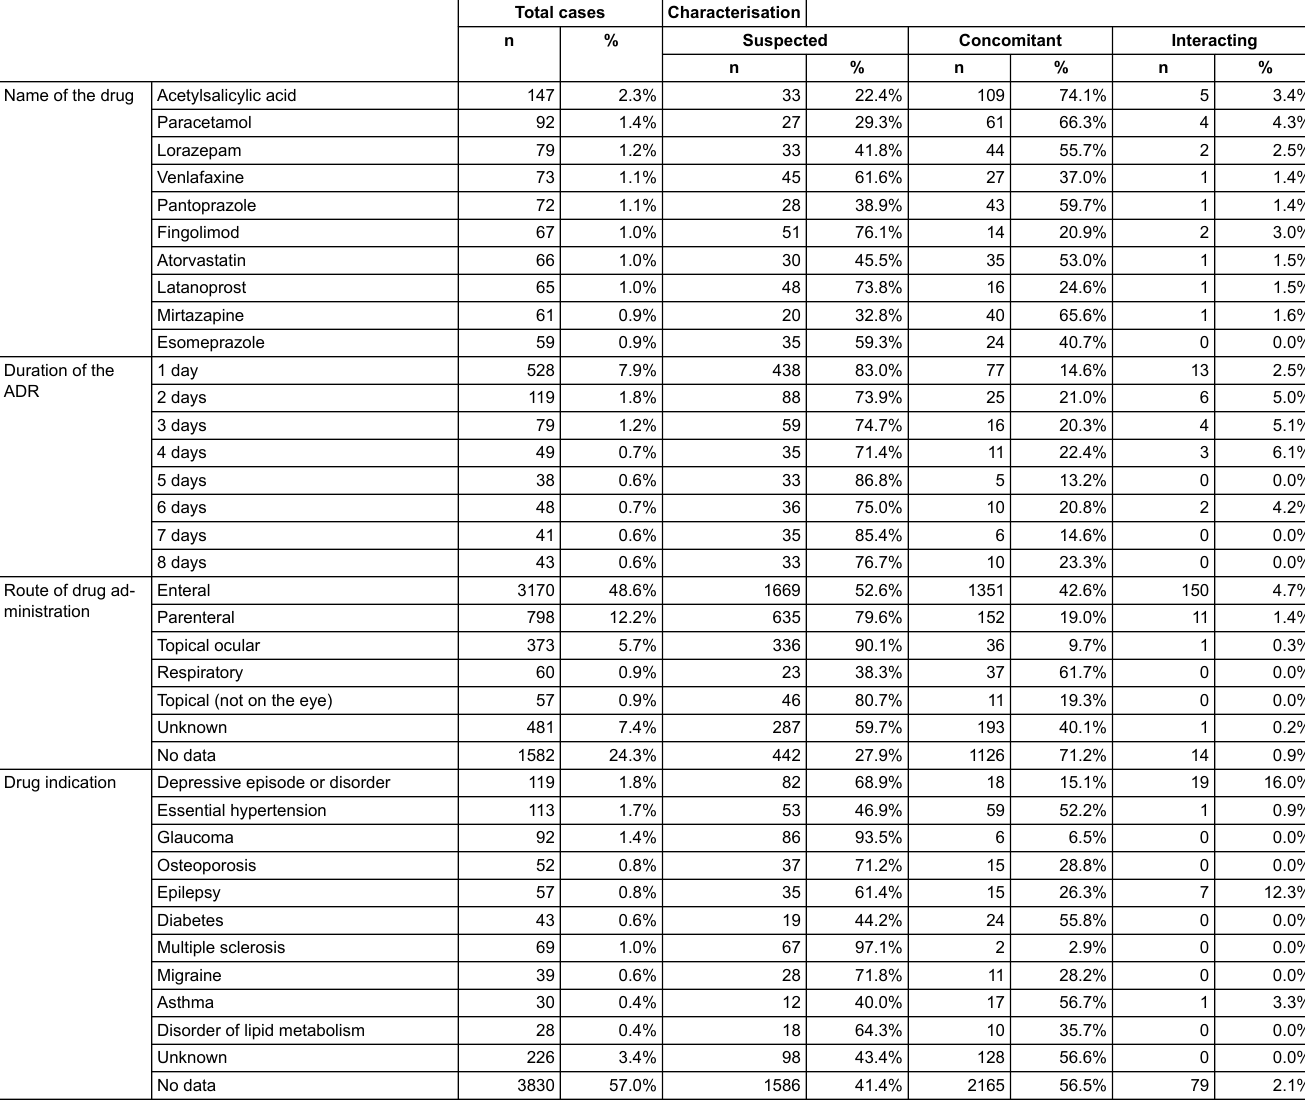
Table 2: Characterisation of the causal relationship between drug and reaction for the different ICSRs sorted by involved medication, duration of the ADR, drug’s route of admin- istration and drug’s